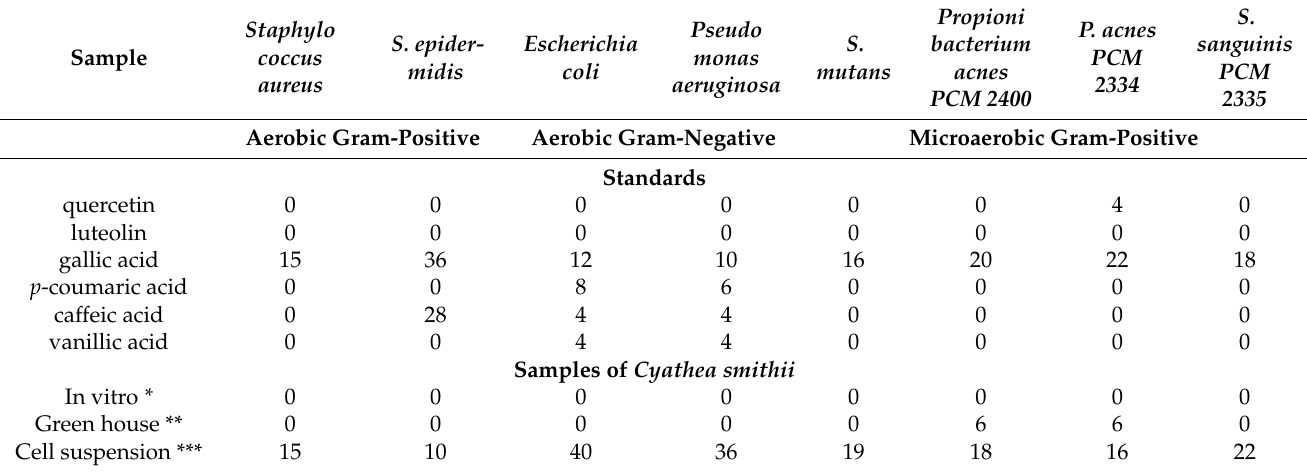
Table 3. Zones of bacterial growth inhibition as antibacterial C. smithii extract